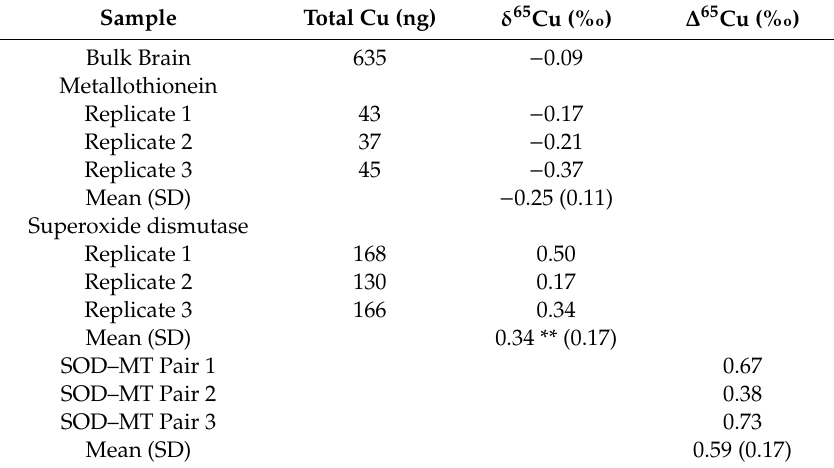
Table 2. The copper isotopic composition of metallothionein and superoxide dismutase as isolated from the brain homogenates of a male Alzheimer’s disease patient. Sample Total Cu (ng) δ 65 Cu (% (cid:24) ) ∆ 65 Cu (% (cid:24) ) 635 −